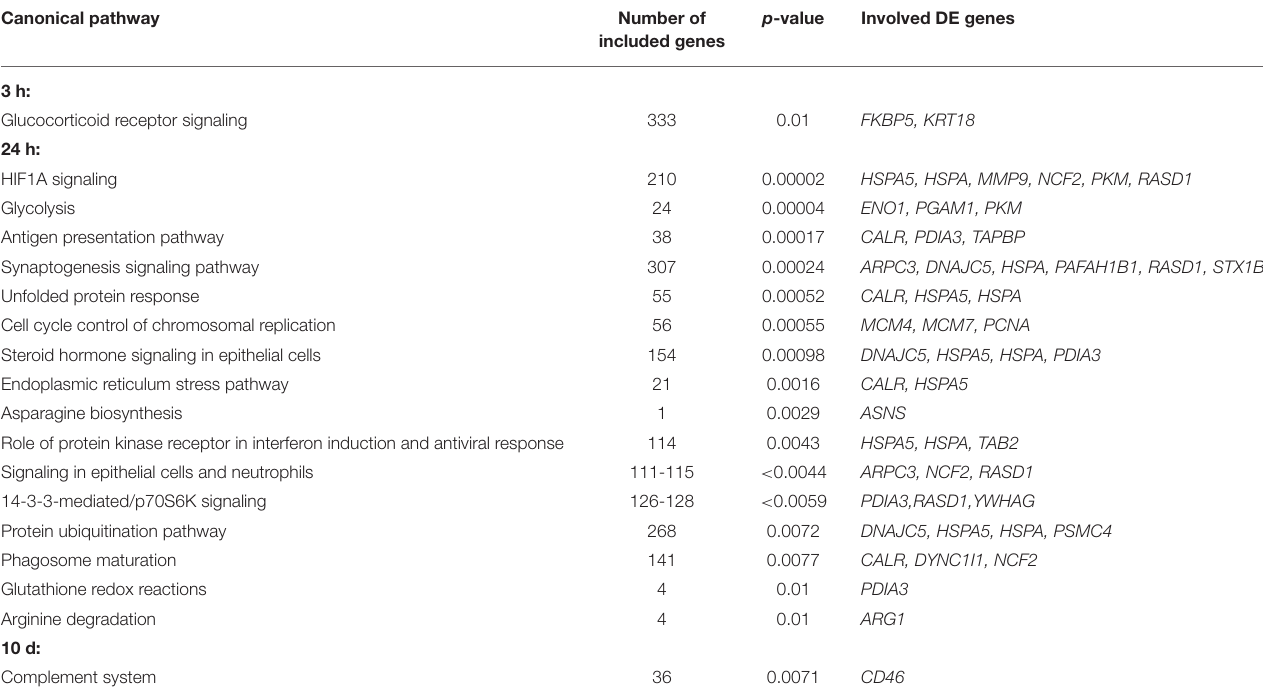
TABLE 2 | Relevant Ingenuity-predicted canonical pathways (with p ≤ 0.01) regulated in challenged maraena whitefish. Canonical pathway Number of